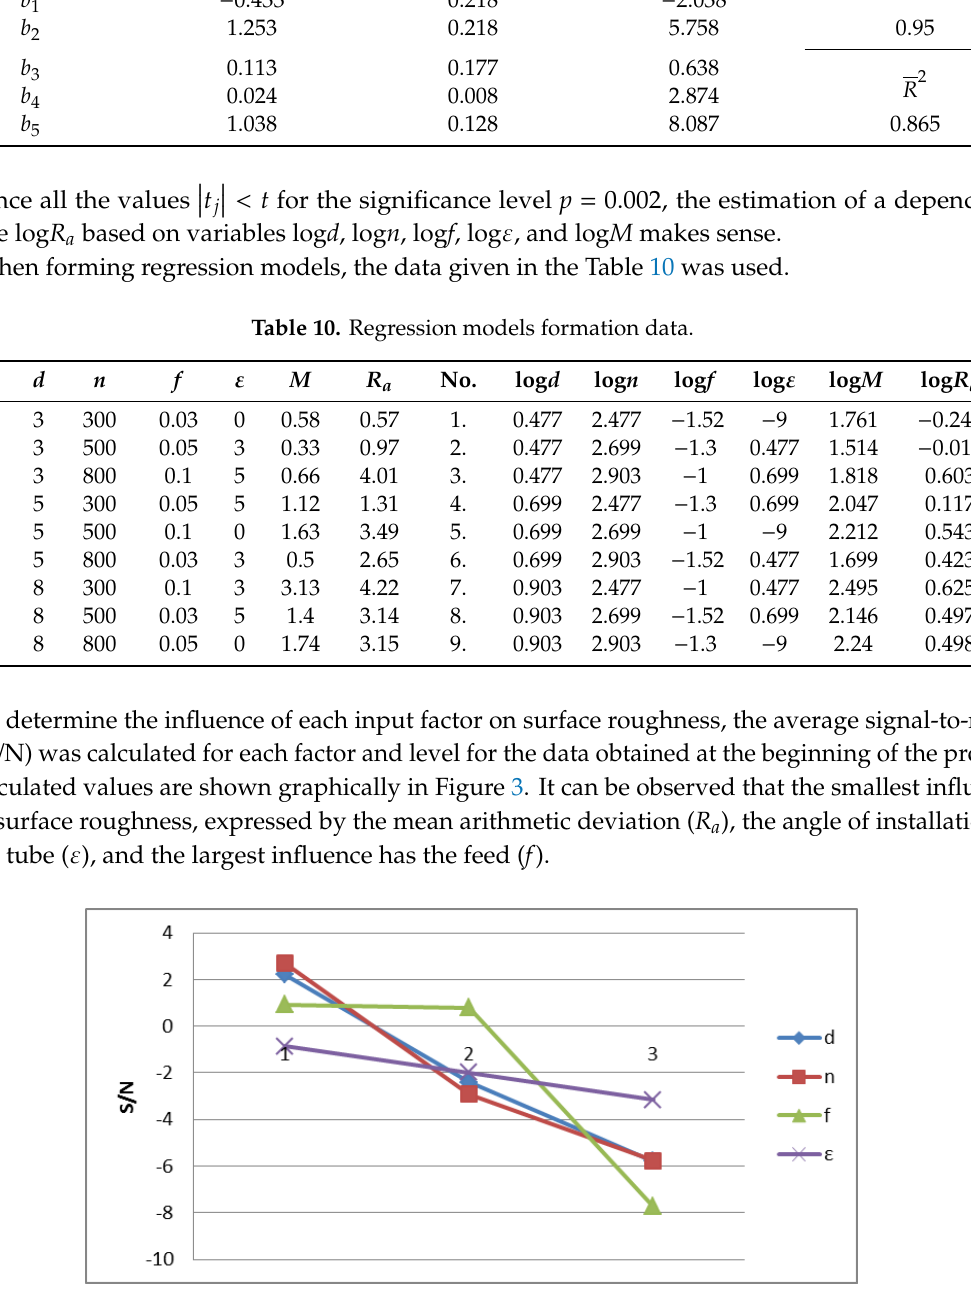
Figure 3. Average signal-to-noise ratio (S/N) ratio of factors and levels.